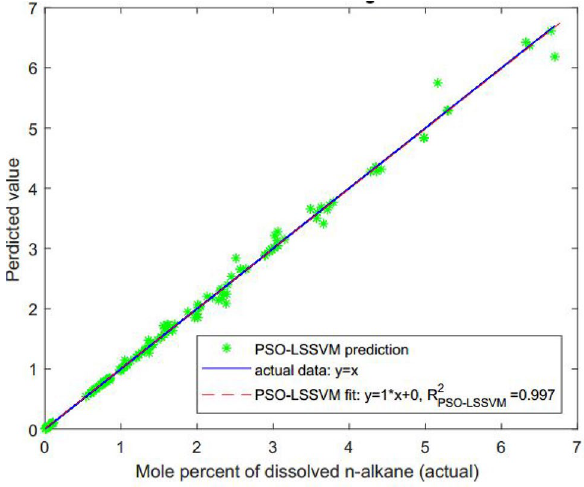
Fig. 2 PSO–LSSVM predicted mole percent of dissolved n- alkane versus actual data for training dataset